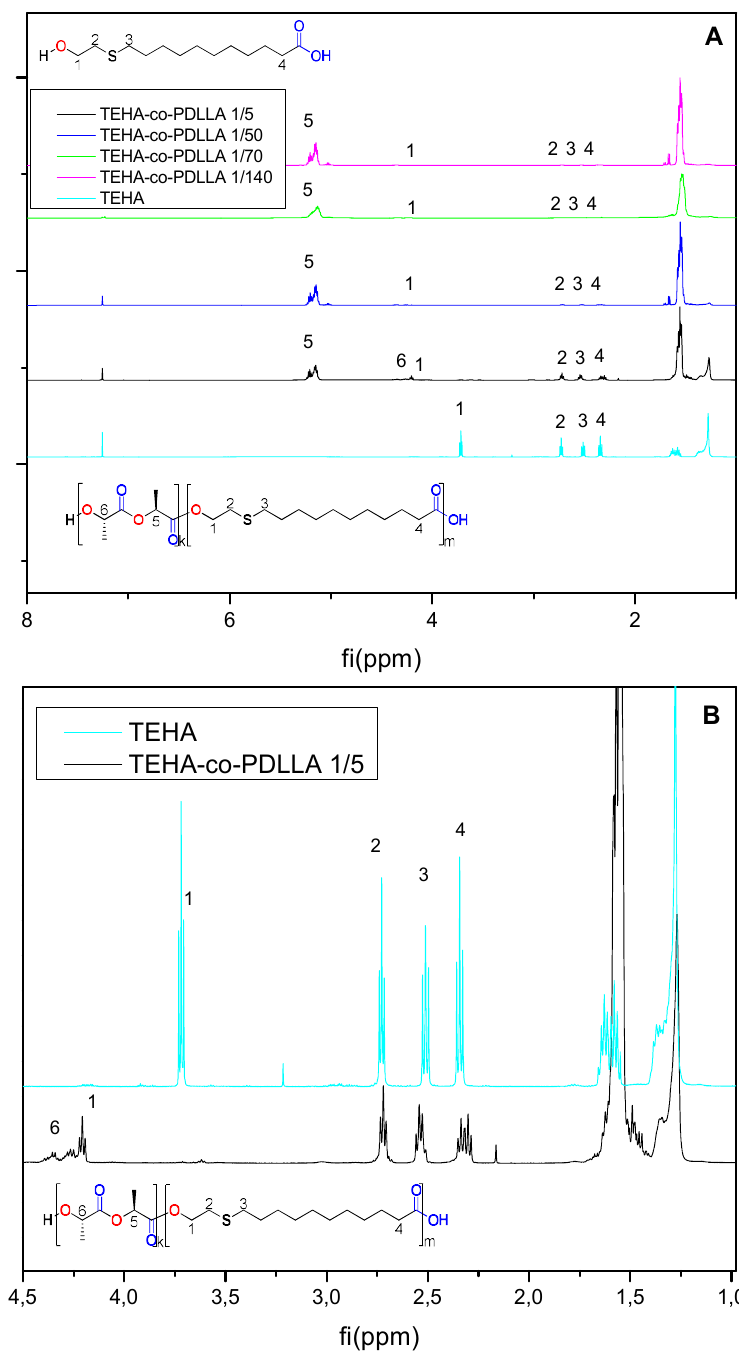
Figure 2. 1 H NMR spectra of ( A ) neat TEHA and TEHA-co-PDLLA semitelechelic block copolymers and ( B ) TEHA and TEHA-co-PDLLA 1/5 copolymer with higher magnification.